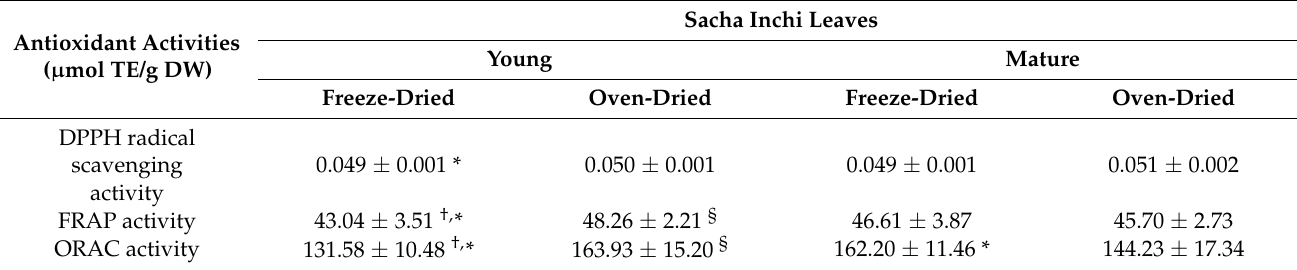
Table 2. Antioxidant activities of aqueous extracts of young and mature sacha inchi leaves dried using freeze-drying and oven-drying processes.